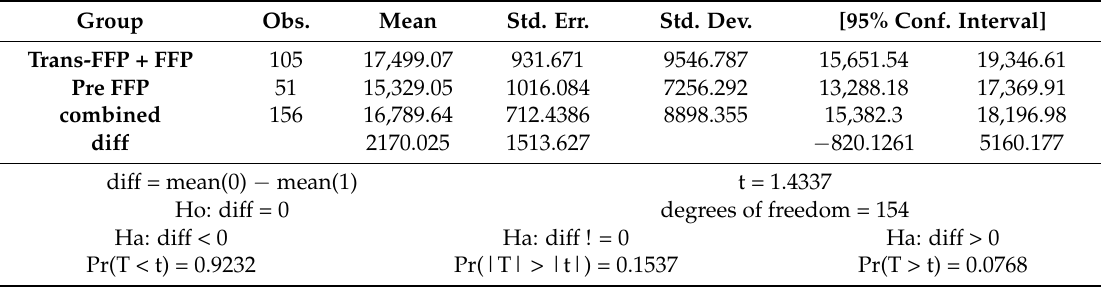
Table 2. Two-sample t-test with equal variances (pre-FFP).